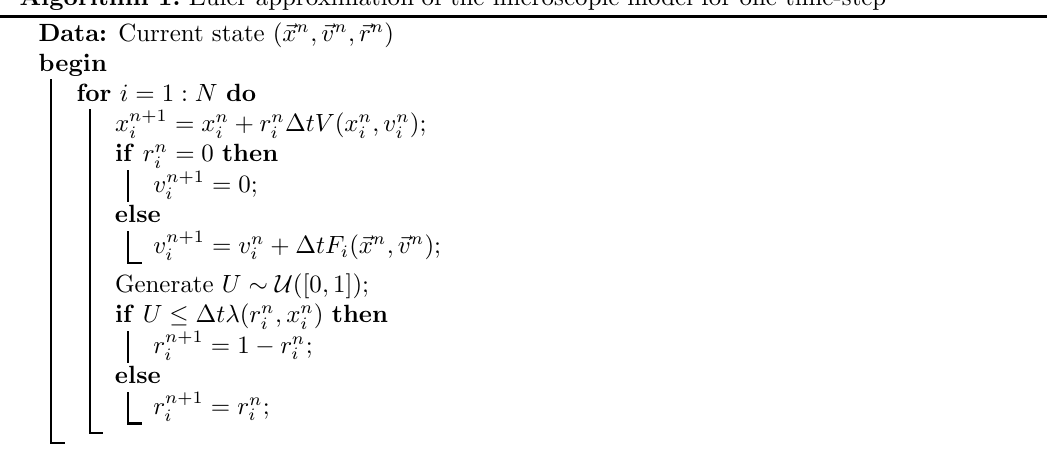
to walk or to stop can be chosen independently i , x n ) where λ is the given rate i i